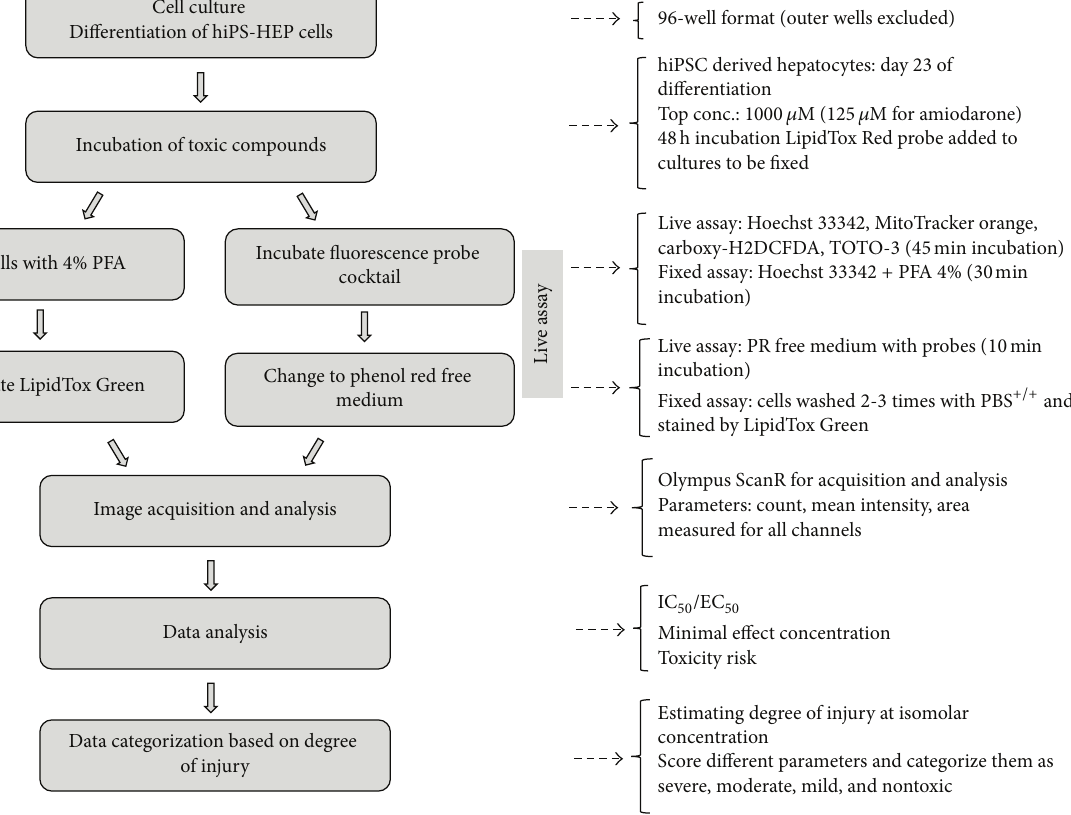
Figure 2: HCA assay scheme for screening drug induced steatosis and